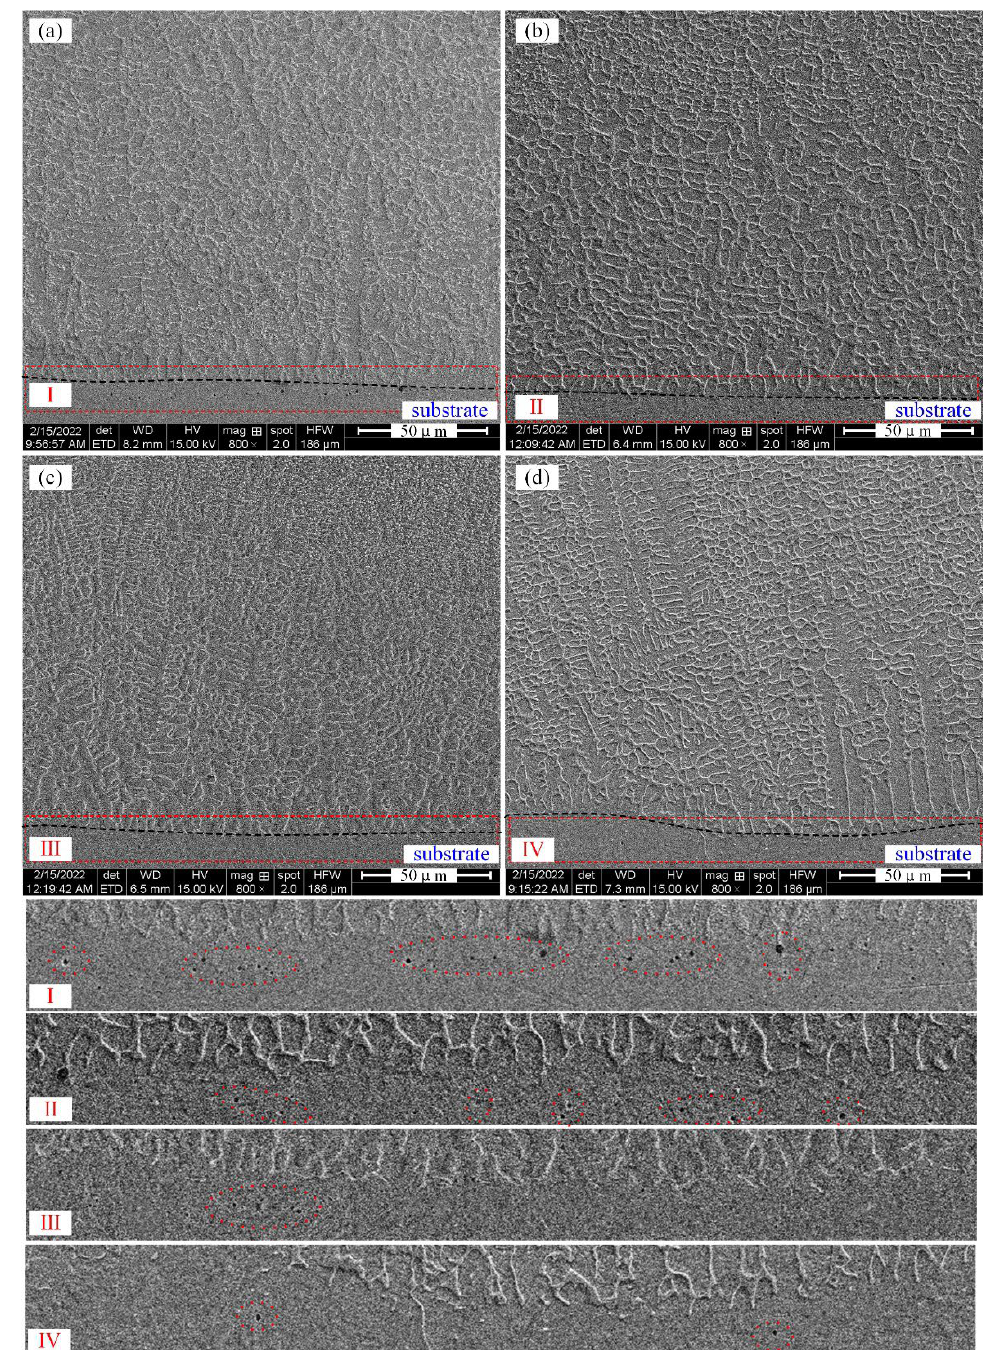
Figure 3. Microstructure near fusion lines of AM alloy deposits. ( a ) Specimen-1, ( b ) Specimen-2, ( c ) Specimen-3, ( d ) Specimen-4.